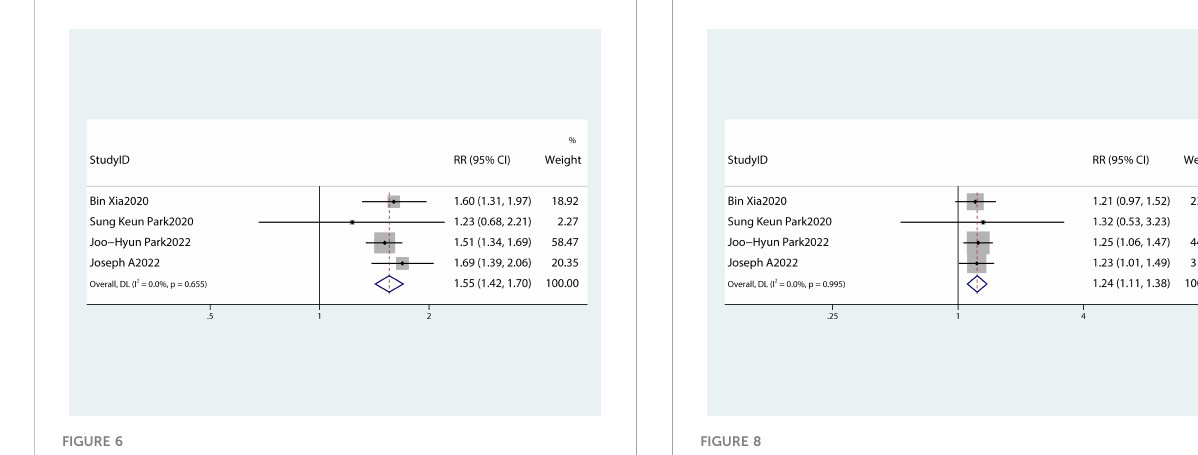
FIGURE 6 A forest plot demonstrating the relationship between hyperglycemia and the risk of pancreatic cancer.